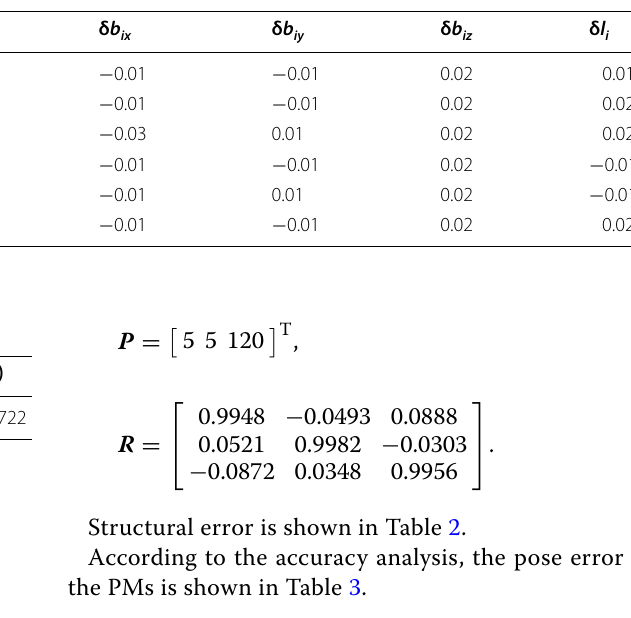
Table 2 Structural error of PM (mm)